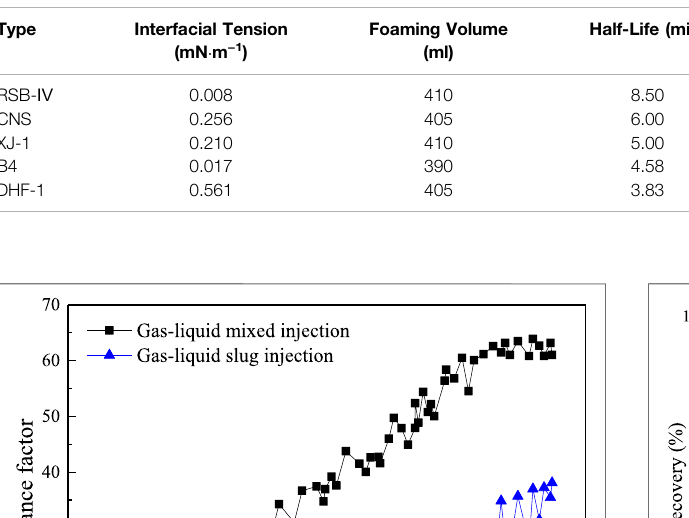
TABLE 2 | Performance of high-temperature resistance foaming agent.